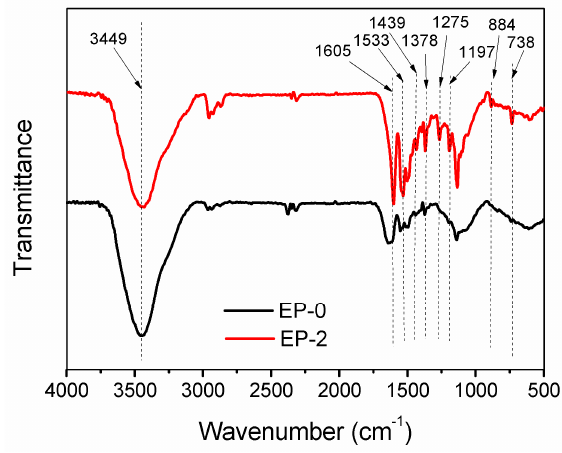
Figure 13. FTIR spectra of the char residue of EP-0 and EP-2 after cone calorimeter test.